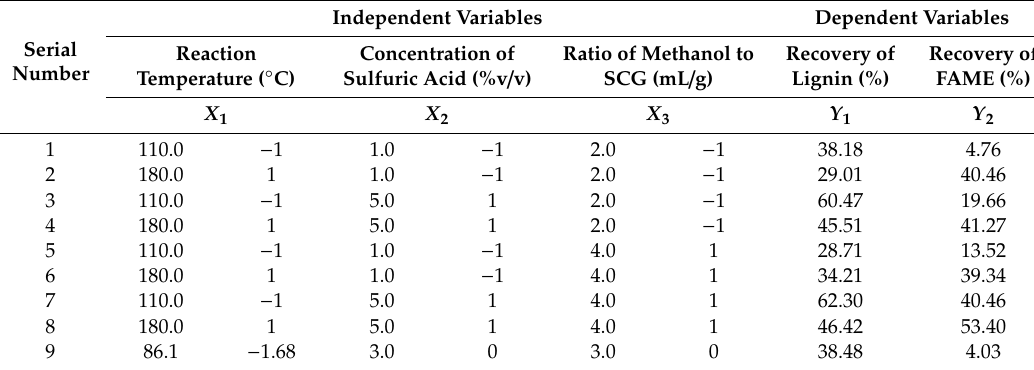
Table 2. Experimental sets with three independent variables and results of recoveries of lignin and fatty acid methyl esters